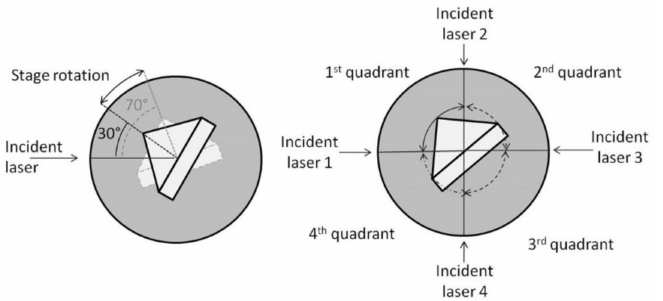
Figure 3. Schematics of the PWR sensor relative to the incident light. On the left we present the maximal range of the prism positioning during a typical PWR spectrum acquisition. On the right is one possible implementation of this setup using up to 4